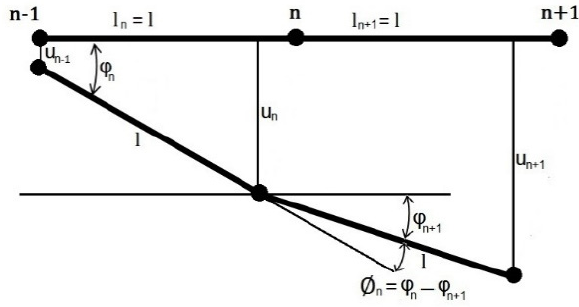
Figure 1. Proposed model of the structure.